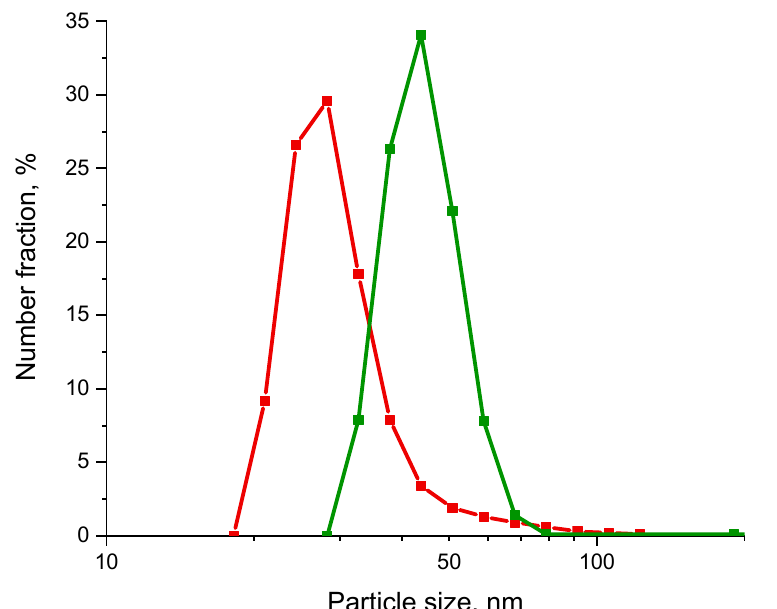
Figure 10. Size distributions of the colloidal particles obtained by dynamic light scattering. The green curve is characteristic of the as-prepared ink, and the red curve is characteristic of the top layer of the ink after 5 days of storage.